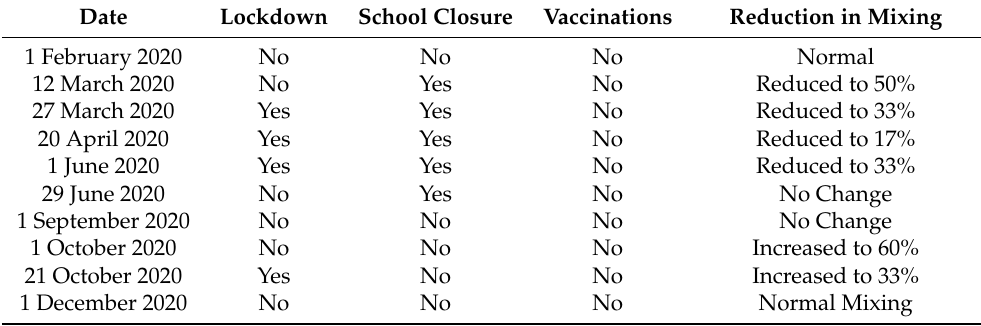
Table 1. Interventions and changes in agent mixing implemented in the